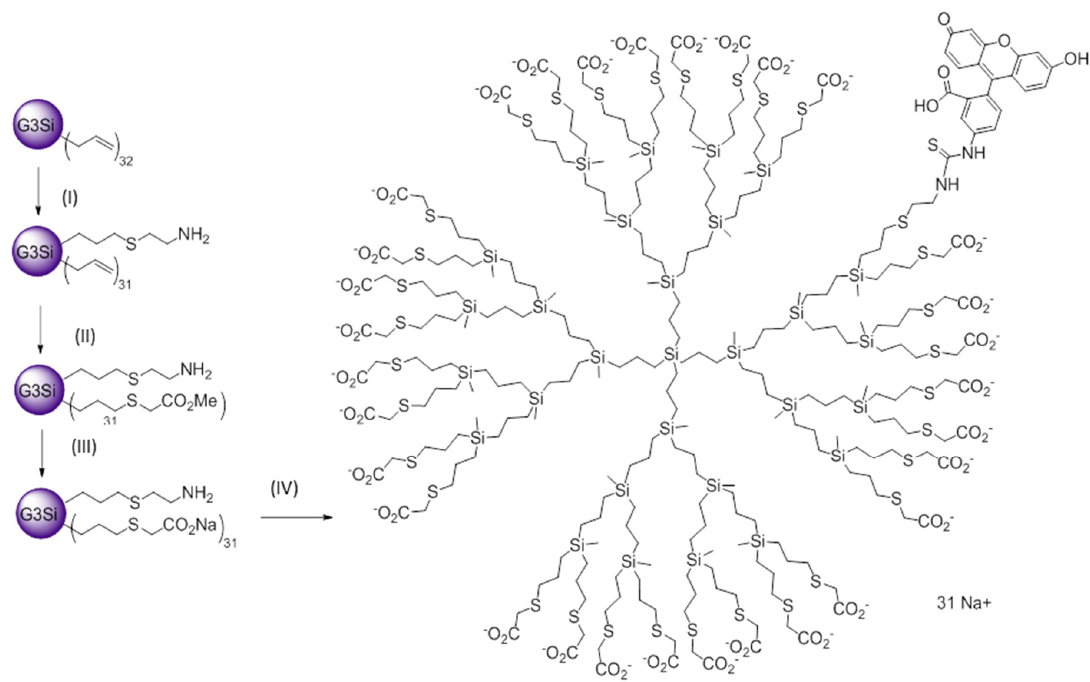
Figure 1. Synthetic route towards FITC-labelled dendrimer IV. (I) HS(CH 2 ) 2 NH 2 ·HCl, MeOH/THF,